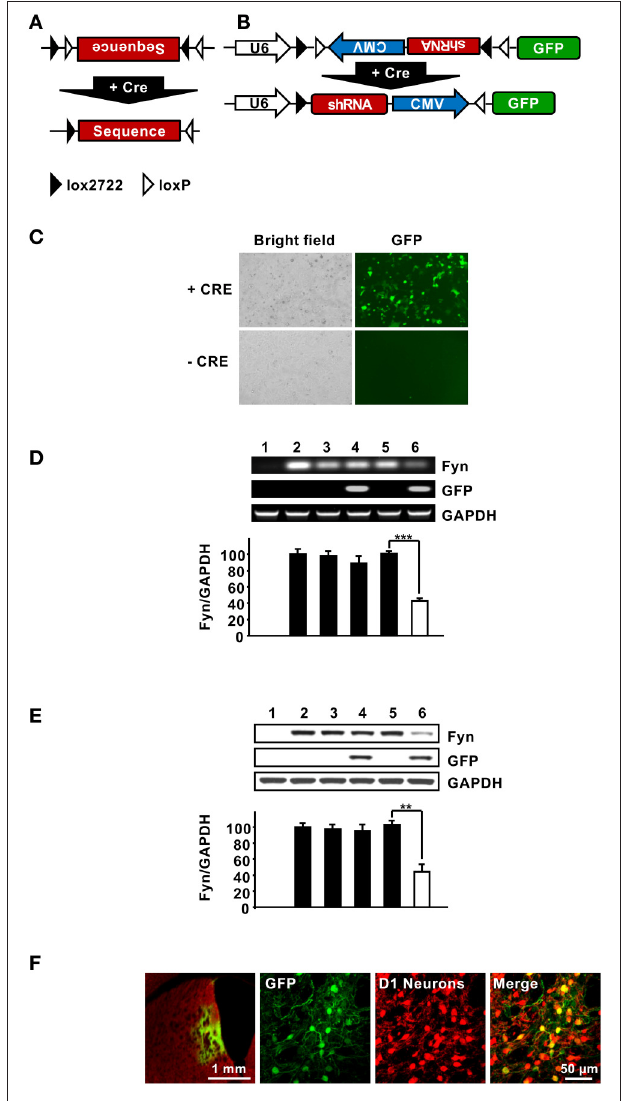
FIGURE 4 | Design and characterization FLEX-Cre system. (A,B) Schematic representation of the FLEX vector which encodes a double-Floxed, inverted shRNA and GFP. In the presence of Cre, a FLip-EXcision (FLEX) switch occurs, leading to a U6 promoter-driven expression of the gene-specific shRNA, and a CMV promoter- driven expression of GFP. (C) The FLEX-shFyn plasmid was incubated with ( + Cre) or without ( − Cre) Cre recombinase in vitro and infection was evaluated by staining cells with anti-GFP antibodies (right panels). (D,E) Characterization of Cre-driven Fyn knockdown in HEK293T cells. (D,E) FLEX-shFyn or FLEX-SCR plasmids were pretreated with ( + Cre) or without Cre recombinase then co-transfected with Fyn plasmid as indicated. mRNA expression (D) and protein levels (E) were analyzed by RT-PCR and western blot analysis, respectively. 1. pUSE-empty plasmid, 2. pUSE-Fyn, 3. pUSE-Fyn + pLVX-FLEX-SCR, 4. pUSE-Fyn + pLVX-FLEX-SCR + Cre, 5. pUSE-Fyn + pLVX-FLEX-shFyn, 6. pUSE-Fyn + pLVX-FLEX-shFyn + Cre. Two-tailed t -test. *** p < 0.001; ** p < 0.01. (D) n = 3, (E) n = 4. (F) Verification of Cre-dependent pLVX-FLEX-shFyn infection in vivo . The DMS of Drd1-Cre-Ai14 mice was infected with Ltv-FLEX-shFyn (2 × 10 7 pg/ml). Colocalization of infected neurons (GFP, green, left panels) with TdTomato (D1R neurons, red, right panels) was determined 3 weeks later. Merged image, right panel. Left panel, 5X; middle and right panels,